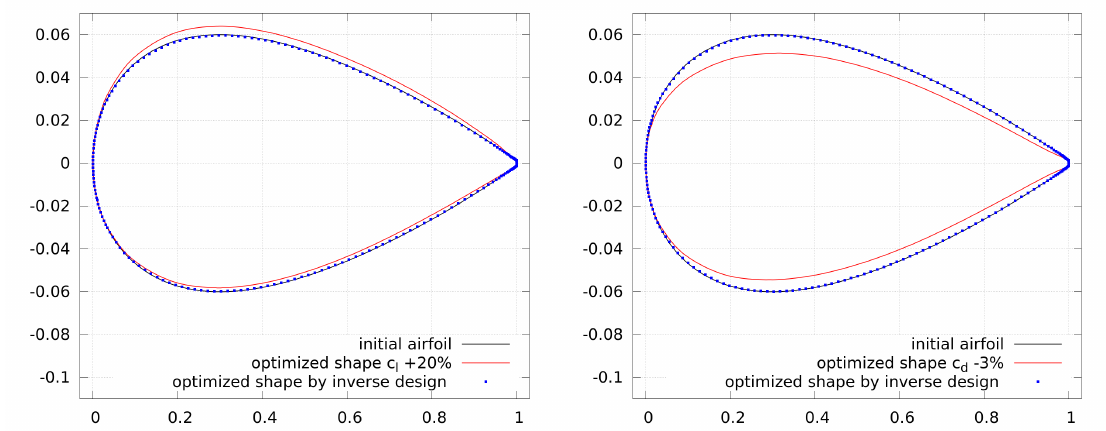
Figure 6. Shapes of inverse design study for the lift objective and drag objective. For a better visualization of the inverse design, only every third point is